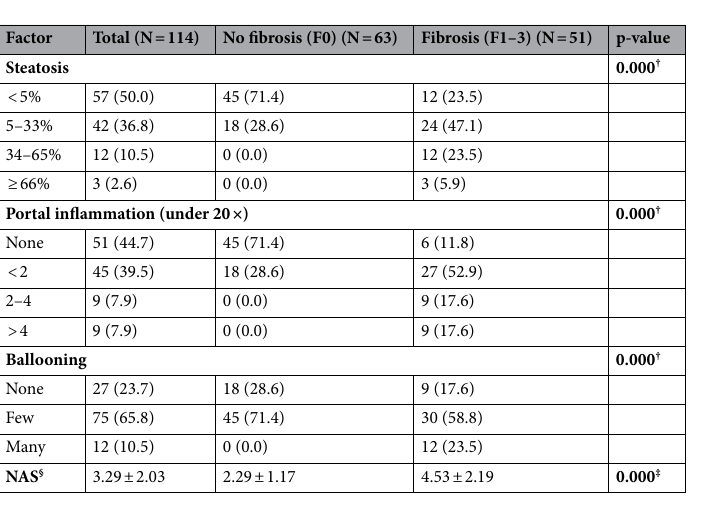
Table 2. Histologic features of the NAFLD patients. Values presented as mean ± standard deviation or N (column %). NAFLD non-alcoholic fatty liver disease, NAS § NAFLD activity score. Fibrosis was scored as F0, no fibrosis; F1, portal fibrosis without septae; F2, portal fibrosis with septae; F3, numerous septae without cirrhosis; and F4, cirrhosis. NAFLD patients and non-NAFLD patients. p-values: † Pearson’s chi-squared test, ‡ Student’s t ‐